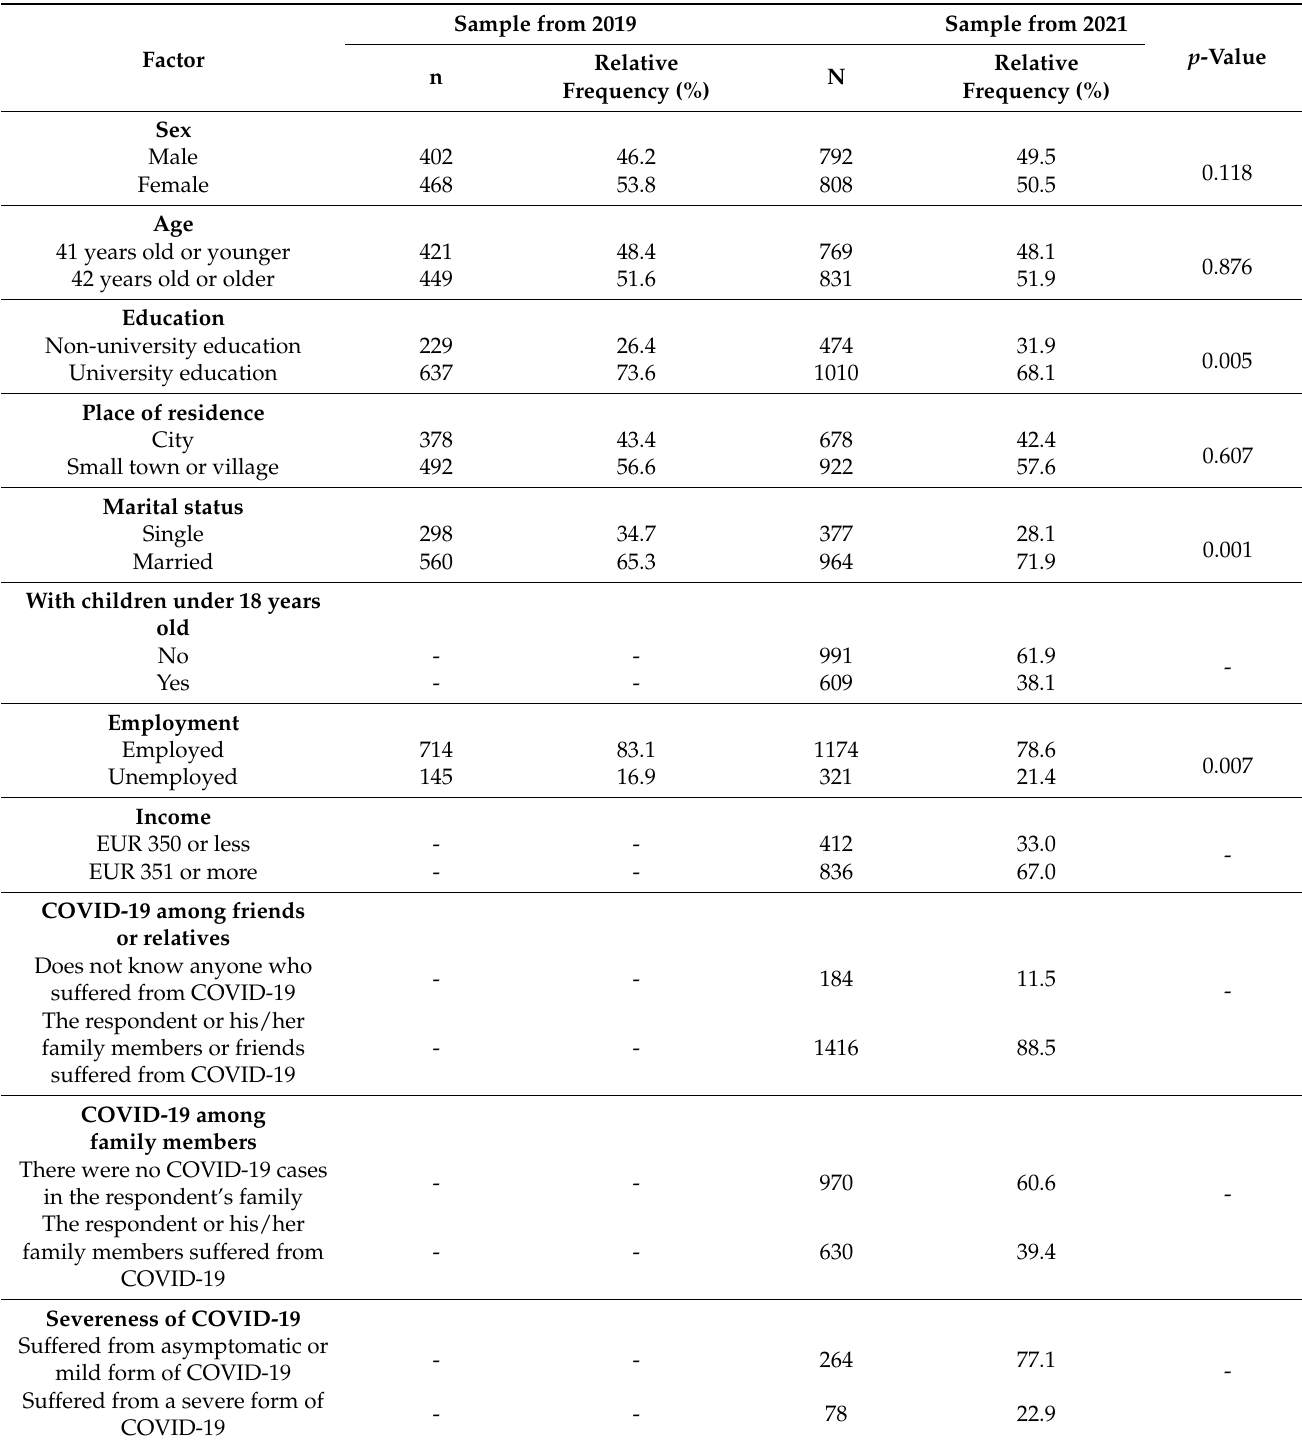
Table 1. Distribution of the respondents by social and demographic factors in both